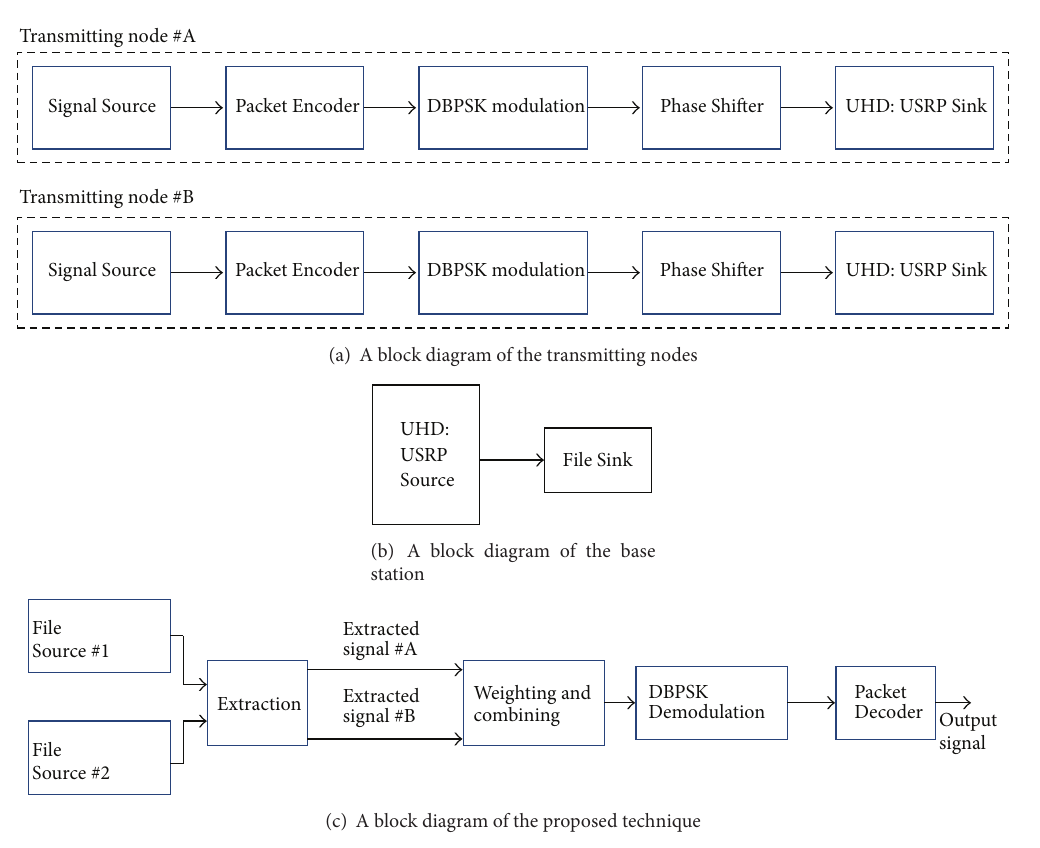
Figure 16: The programming block diagram experimental